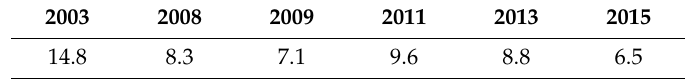
Table 4. Evolution of groundwater availability in the Cuautrola-Yautepec Aquifer,